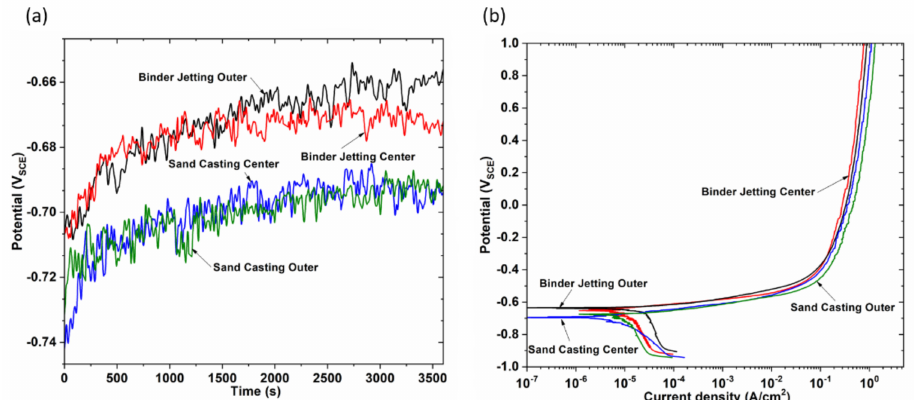
Figure 8. OCP evolution of binder jetting and of sand mold ( a ) and anodic polarization scans in the binder jetting and in the sand mold ( b ) in 3.5% NaCl, center and outer sections.